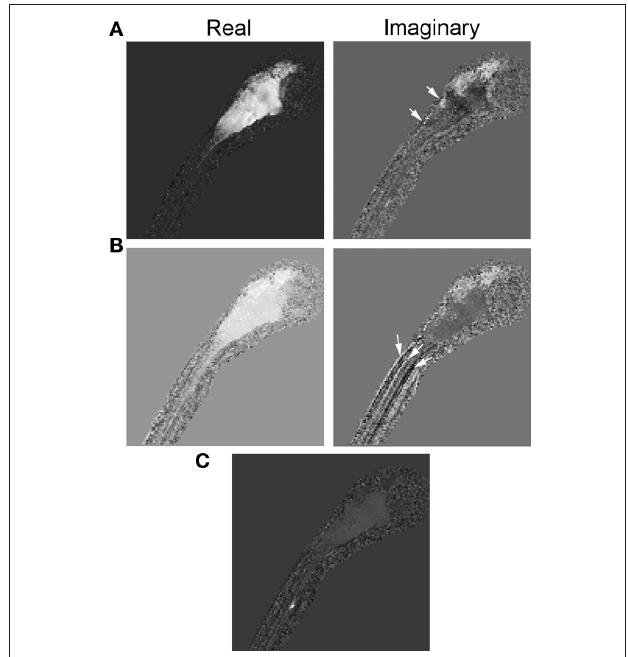
Figure 7 | eigenvectors of the reduced connectivity matrix, K estimated using an SVD decomposition. Each eigenvector represents a dynamical mode of neuronal activity calculated from the estimated firing rates. (A,B) represent dynamical modes with complex eigenvalues and therefore they are wave-like modes with firing rates propagating between the real and imaginary parts of the eigenvector. A few regions exhibiting significant but localized differences between eigenvectors (A,B) are indicated (arrows). (C) Represents a dynamical mode with a real eigenvalue and thus a non-propagating mode. In this case, a single neuron or group of neurons (the region of bright pixels) in the spinal cord fired independently of other neuronal activity. CNS regions and scale are given in Figure